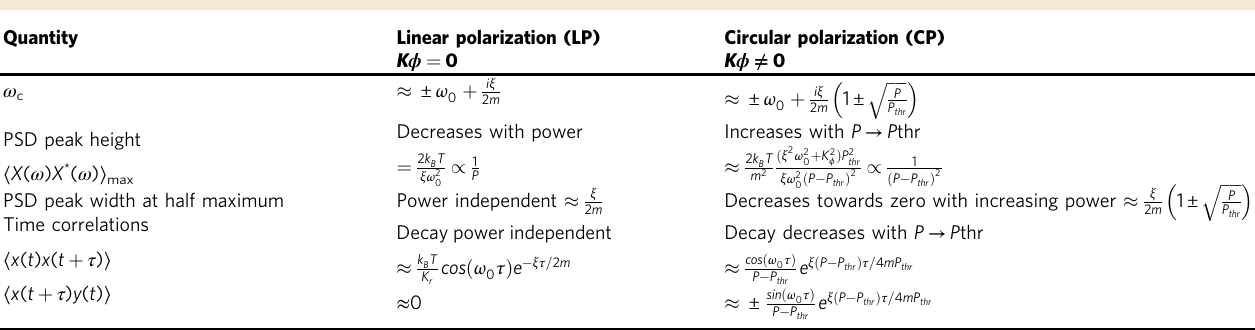
Characteristic frequencies, ω c , PSD characteristics and time correlations describing under-damped stochastic motion in circularly and linearly polarized